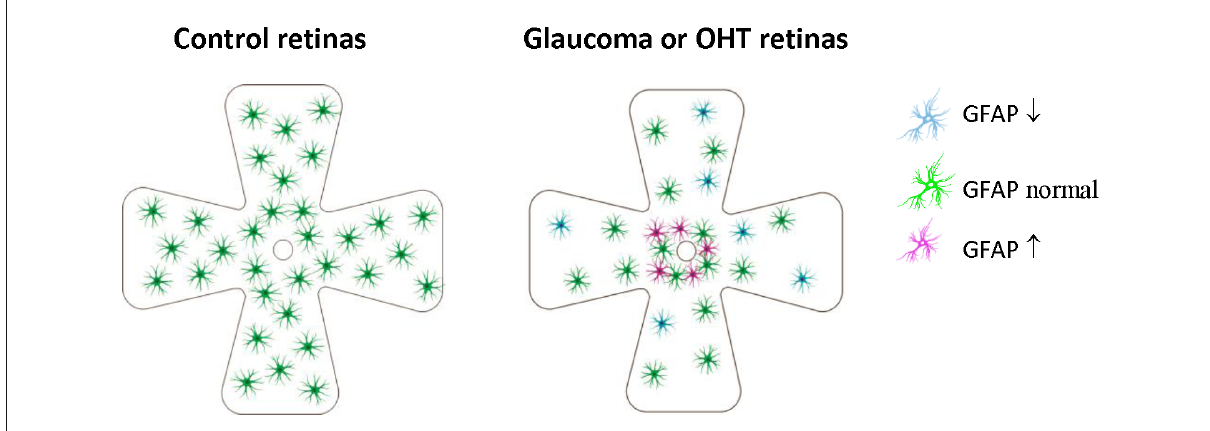
FIGURE3 Retinal astrocyte activation in glaucoma is heterogeneous and is stage-dependent and spatially dependent. In the early stage of OHT/glaucoma, or the peripheral retina of late-stage glaucoma, cell density and GFAP expression of astrocytes are reduced. Astrocyte activation seems only to occur in some retinal areas of later-stage glaucoma, especially areas close to ONH. OHT, ocular hypertension; ONH, optic